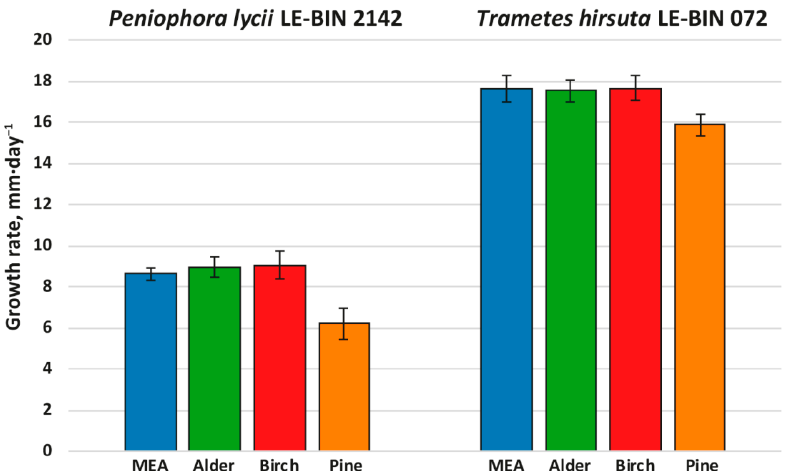
Figure 1. Growth rates of P. lycii LE-BIN 2142 and T. hirsuta LE-BIN 072 during their cultivation on MEA media containing various types of sawdust—alder, birch and pine. The MEA medium without sawdust addition was used as a control.